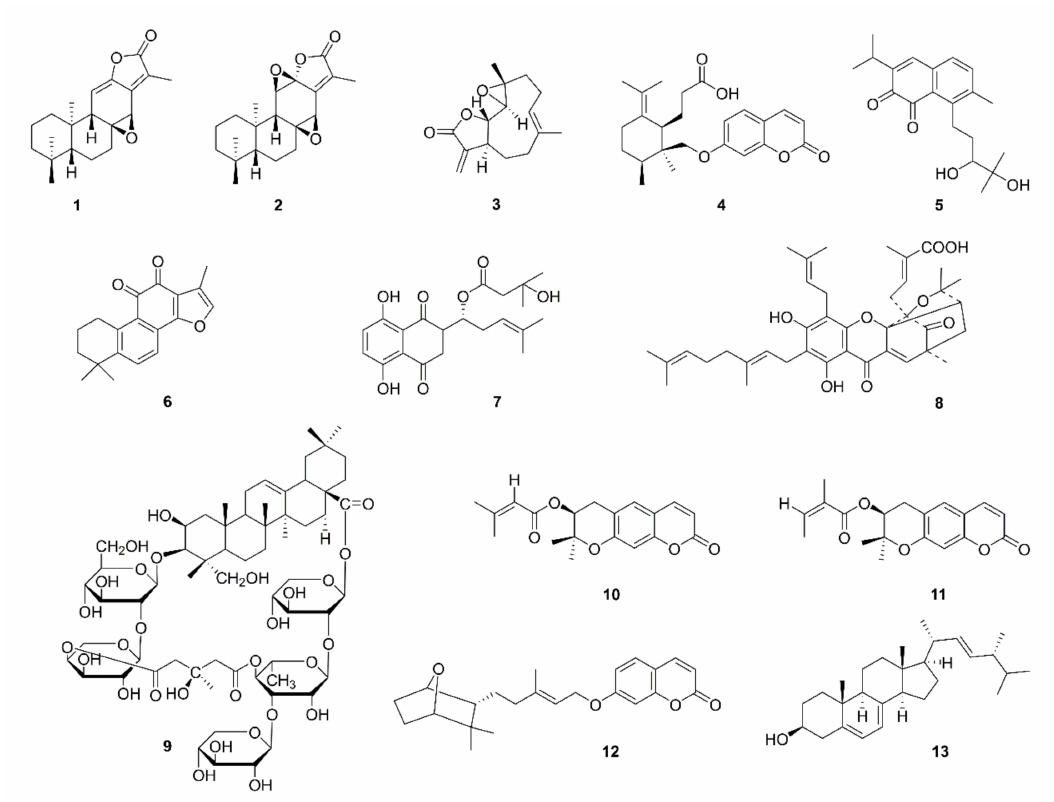
Figure 2. Chemical structures of natural compounds targeting angiogenesis ( 1 – 13